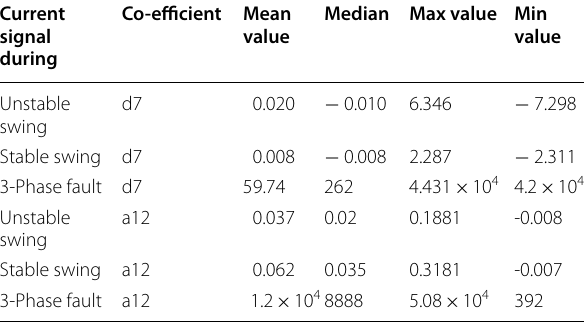
Table 3 d7 and a12 coefficients during the unstable, stable, and faulty conditions